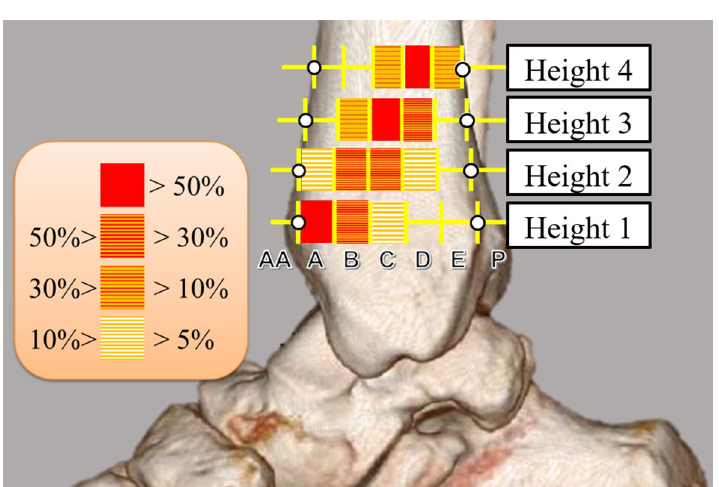
Figure 4. Prevalence of the great saphenous vein at each location. The prevalence of the great saphenous vein in each segment (AA-P) at each height (height 1–4) is